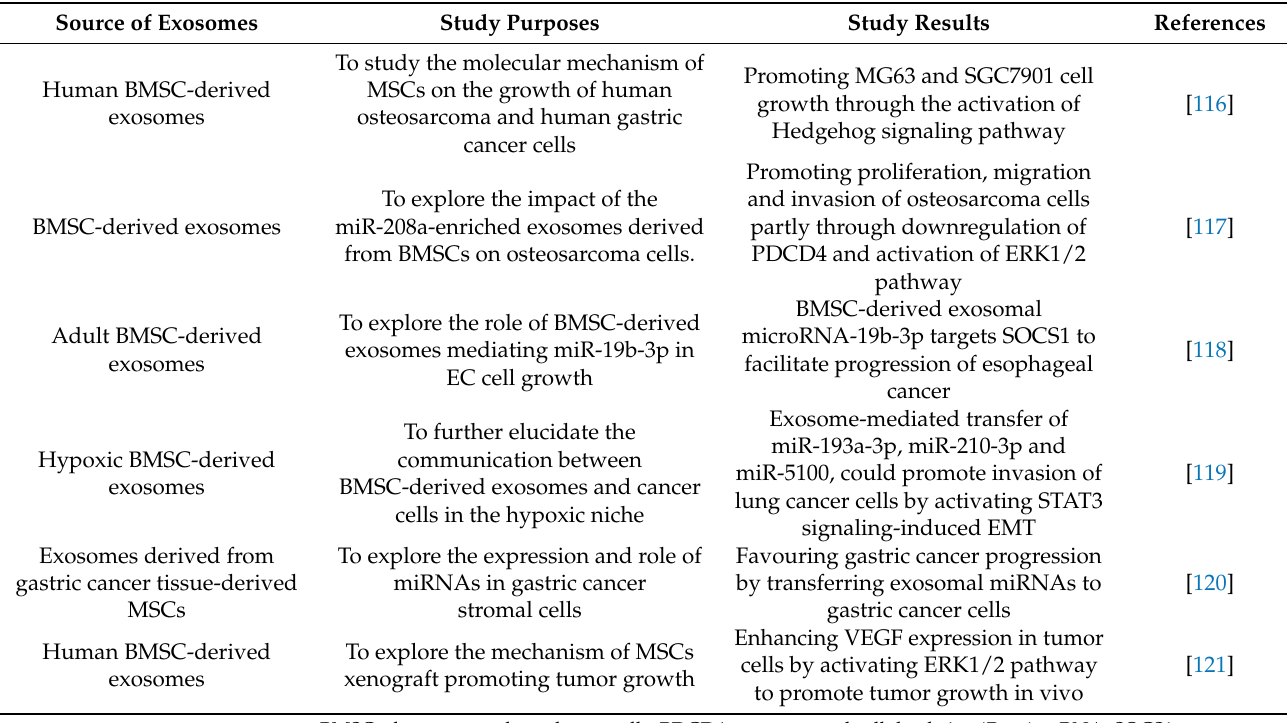
Table 2. Studies showing promotion of tumor progression by MSCs-derived